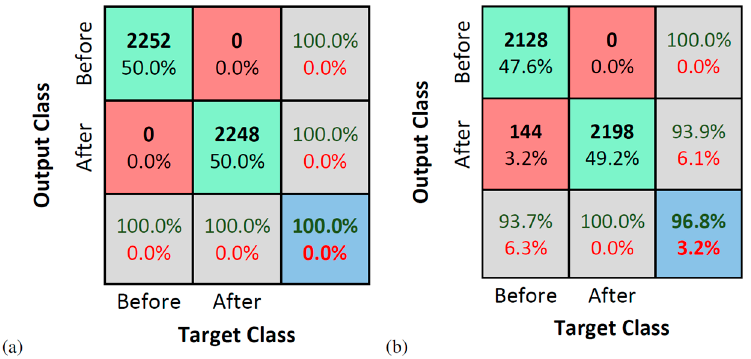
Figure 14. Várzea Nova viaduct: Confusion matrices—100 SAE internal codes. ( a ) Accelerometer 1.